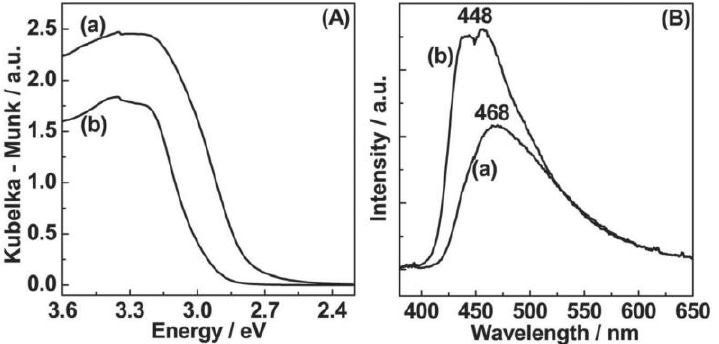
Figure 5. UV-visible absorption spectra ( A ) and fluorescence emission spectra ( B ) of: (a) bulk g- C 3 N 4 and (b) g-C 3 N 4 nanosheets. The wavelength of excitation light for fluorescence emission spec- tra is 350 nm. Reprinted with permission from Ref. [52]. Copyright 2012 John Wiley and